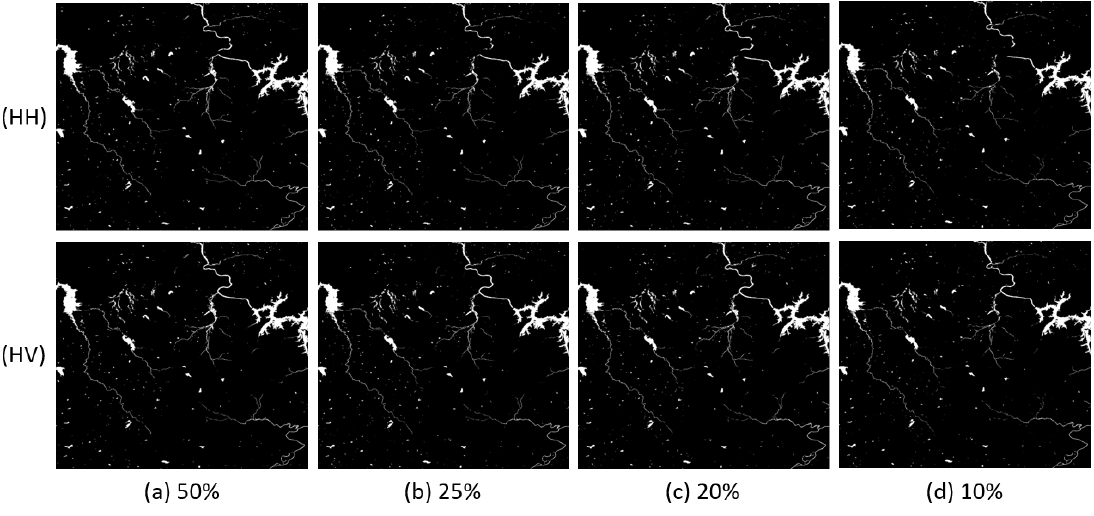
Figure 9. Results comparison of Scene 2 with different p: ( a ) p = 50%; ( b ) p = 25%; ( c ) p = 20%; and( d ) p =